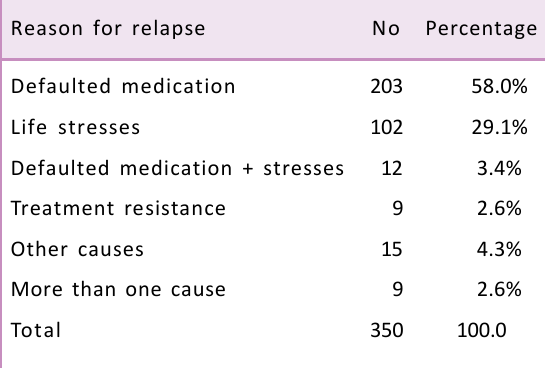
Table 1. Reasons for relapse among study